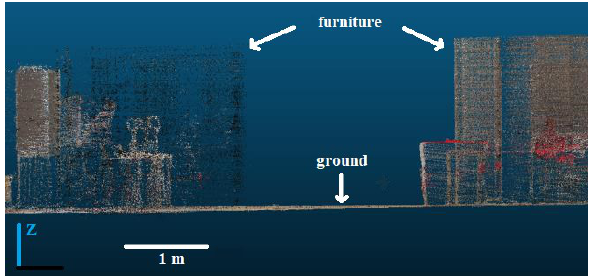
Figure 9: Vertical slice in the LiBackPack point cloud